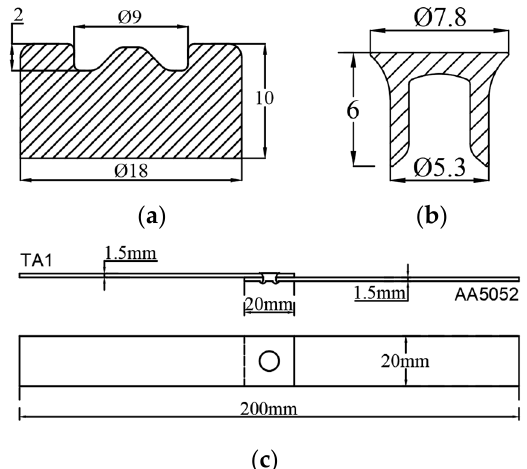
Figure 1. The geometric dimensions of ( a ) bottom die; ( b ) rivet; ( c ) lap